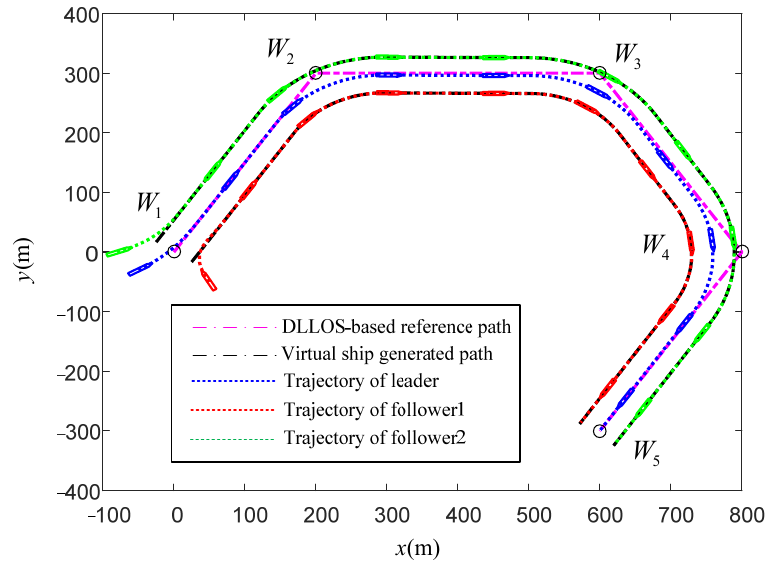
Figure 4. The formation trajectories for USVs with the DLLOS guidance.